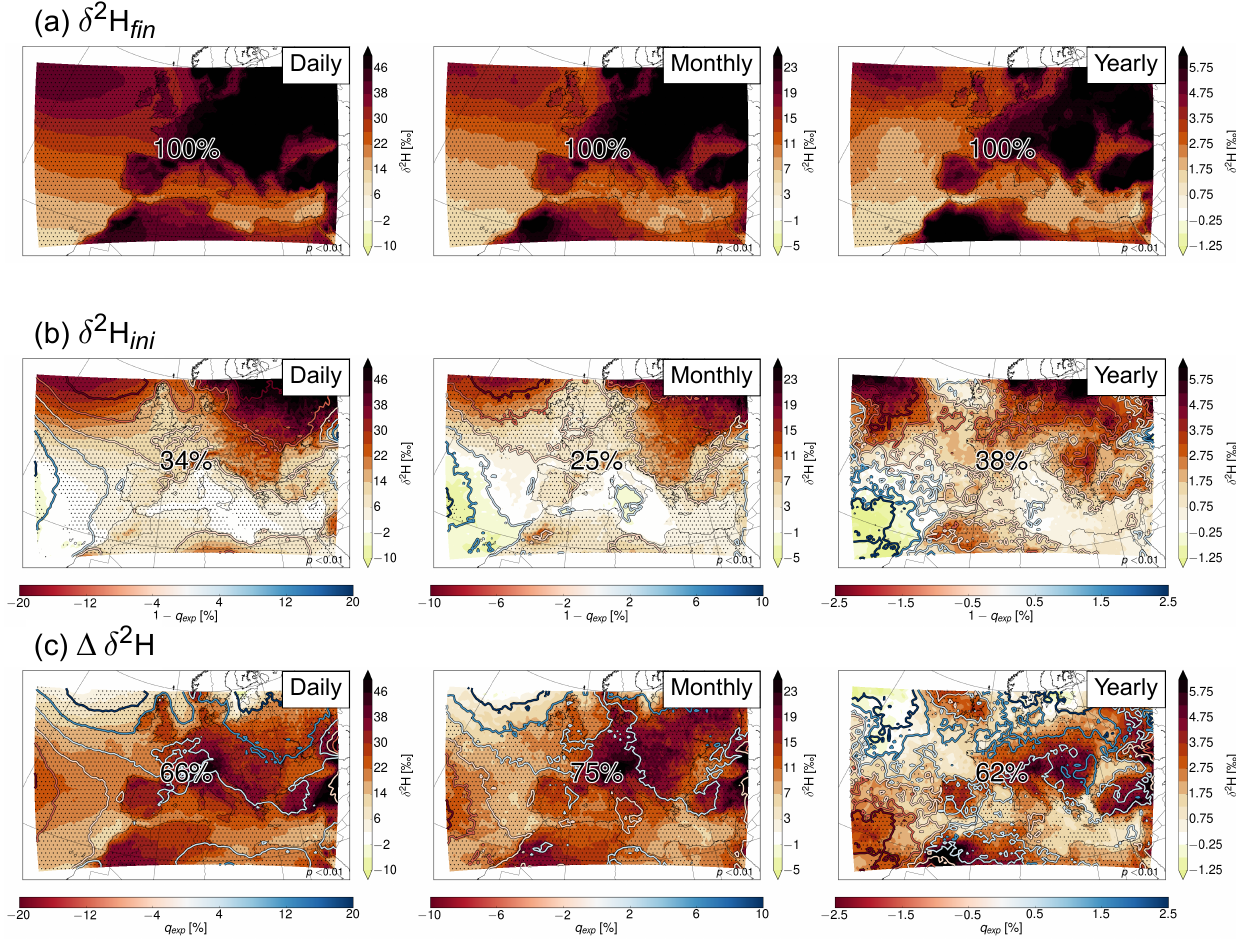
Figure 10. Difference in δ 2 H between the high and low anomaly days (left), months (middle), and years (right) at each grid point. (a) Shows the mean δ 2 H in water vapour averaged over the first, third, and fifth lowest model level and (b, c) show the weighted contributions of the initial values and the changes along the trajectories, respectively. The numbers show the mean contribution of each term to δ 2 H fin , and the contours show the difference in 1 − q exp (b) and q exp (c) in %. Stippling indicates areas where p < 0 . 01. Note the different colour